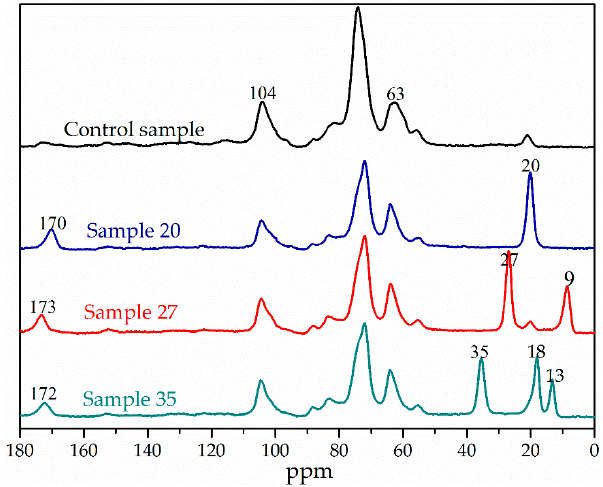
Figure 2. Solid state CP/MAS 13 C-NMR spectra of the control sample and SCB acetate (sample 20), propionate (sample 27) and butyrate (sample